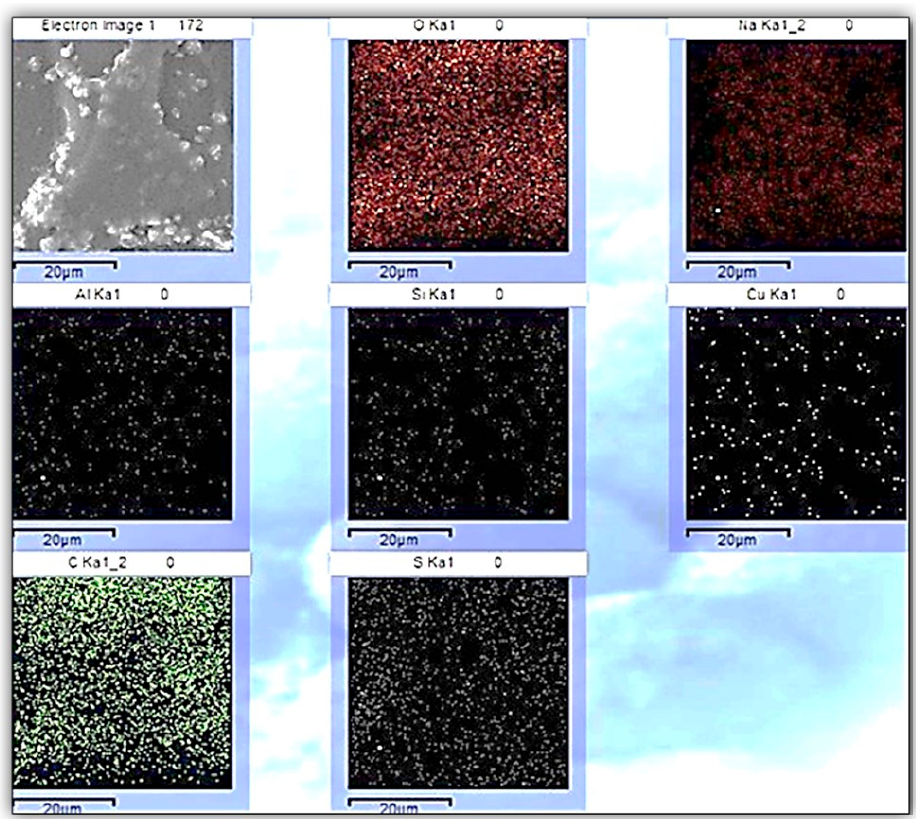
Figure 5. EDX Mapping of S50P50D15.